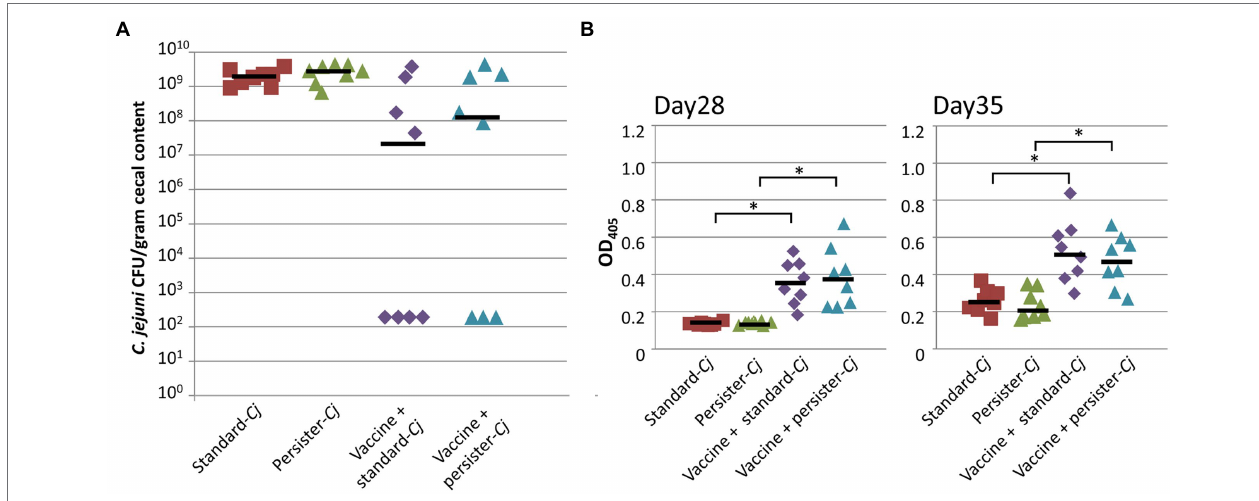
FIGURE 7 | Challenge with “persister” C. jejuni 81-176 has no effect on vaccine performance. (A) Colonization of 35-day-old broiler birds. C. jejuni levels [expressed as colony forming units (CFU) per gram of chicken cecal contents] after vaccination (with 1 × 10 8 live E. coli vaccine on day 7 and 21) and challenge. Birds were challenged with either 1 × 10 6 “standard” C. jejuni 81-176 (standard- Cj , n = 8) or with 1 × 10 6 C. jejuni 81-176 recovered from vaccinated bird that were still colonized (persister- Cj , n = 8) on day 28. Standard- Cj and persister- Cj groups ( n = 8) were not vaccinated, but challenged on day 28. No statistical difference in CFU (Fisher’s exact test) was observed between the standard and persister groups. (B) The N-glycan-specific immune responses. ELISA results using a 1:10 dilution of chicken sera from bleeds taken before challenge (day 28, upper panel) and at the day of euthanasia (day 35, lower panel). Each point represents the N-glycan- specific IgY antibody response measured at OD 450 for each individual chicken. Black bars represent the median for each group. * statistically significant; two-tailed t -test, p <